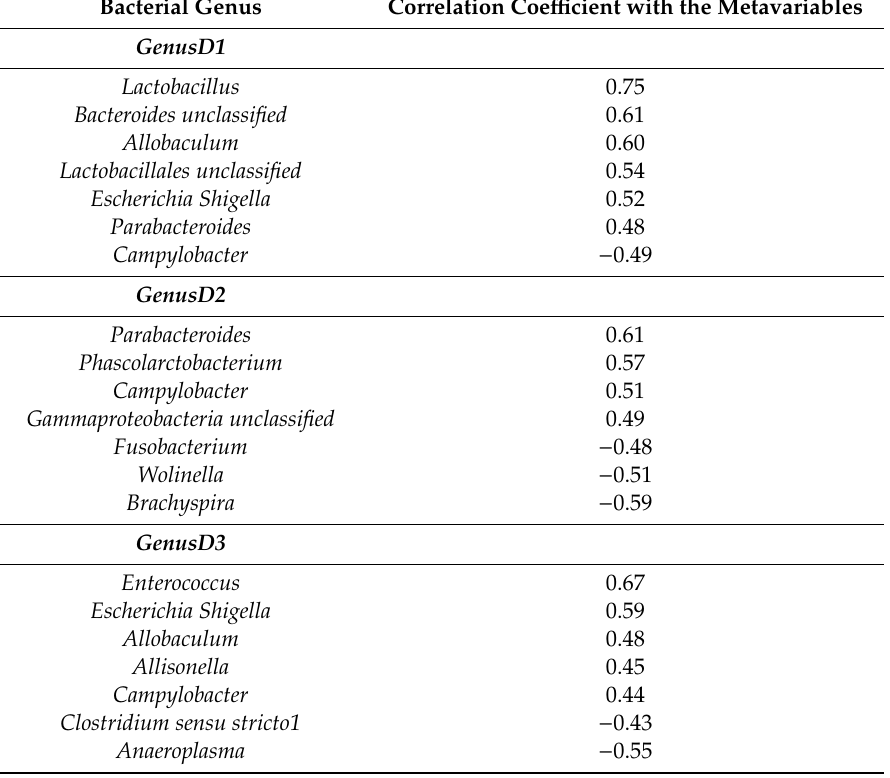
Table 7. Main metabolites associated with each metavariable and correlation between each metabolite and the